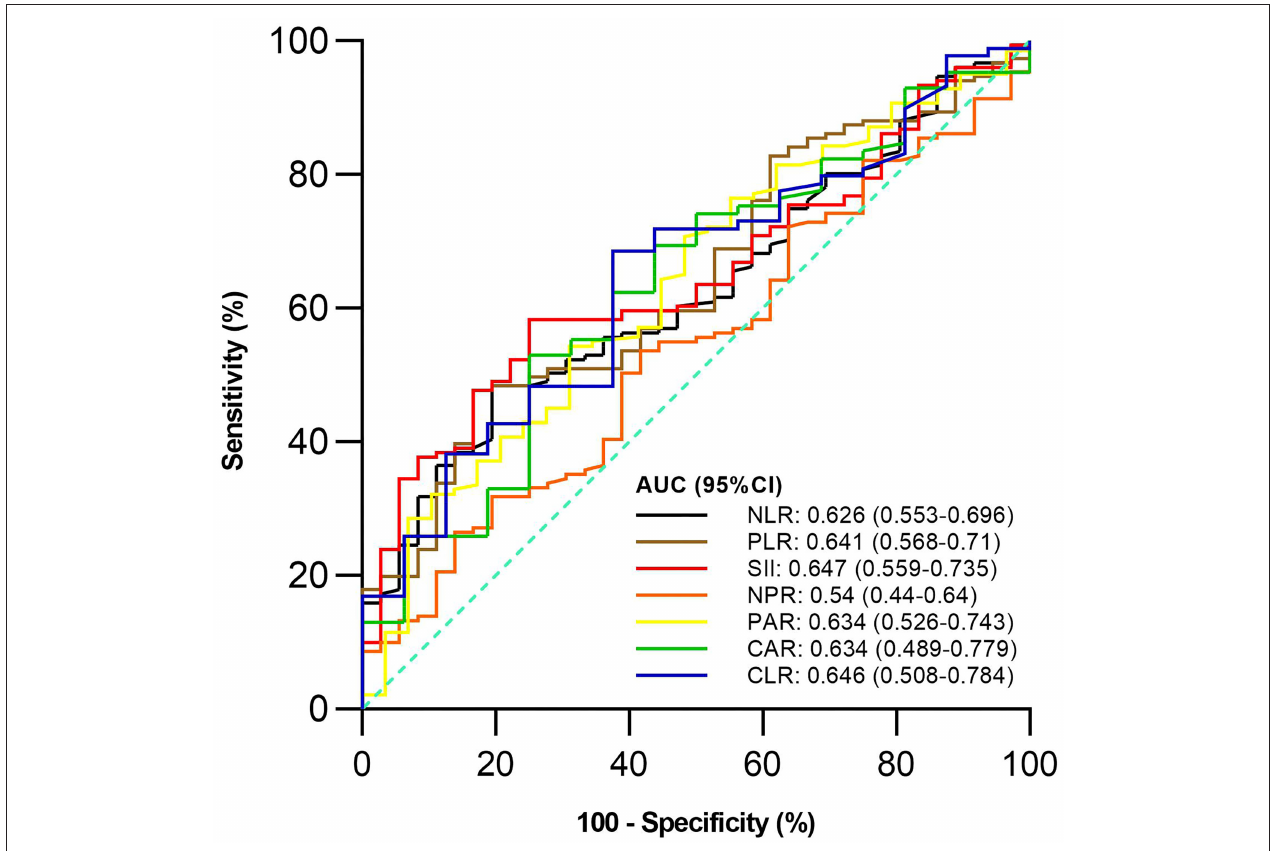
FIGURE 2 | Comparison of predictive performance of inflammatory indexes for active ulcerative colitis (UC). UC, Ulcerative colitis; AUC, Area under the curve; CI, Confidence interval; NLR, Neutrophil-to-lymphocyte ratio; PLR, Platelet-to-lymphocyte ratio; SII, Systemic immune-inflammation index; NPR, Neutrophil-to-platelet ratio; PAR, Platelet-to-albumin ratio; CAR, C-reactive protein-to-albumin ratio; CLR, C-reactive protein-to-lymphocyte ratio. SII, and PAR ( P = 0.019, 0.009, 0.006, and 0.023), but not NPR, CAR, or CLR ( P = 0.457, 0.091, or 0.064), were significantly higher in the active group than in the remission group ( Table 2